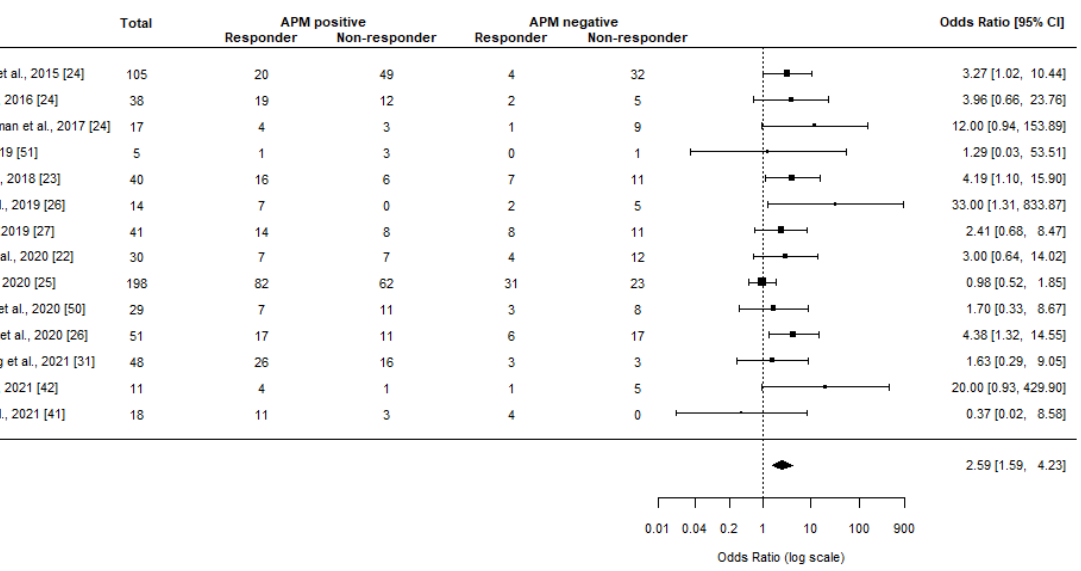
Figure 3. Meta-analyses investigating the association between normal APM (no mutations and/or normal RNA/protein expression of the relevant genes) and clinical benefit from ICI treatment. The black box represents the point estimate for the respective study, while the vertical line is the 95% CI. Gene Expression Omnibus (GEO) datasets from Hugo et al. [28] and Van Allen et al. [36] were re-analyzed in line with the objectives of this review in Sade-Feldman et al. [24]. Gide et al. [30] was reported in Yoshihama et al. [27], Huang et al. [29] was re-visited by Thompson et al. [26], while Balatoni et al. [52] was re-analyzed by Ladányi et al. [22].